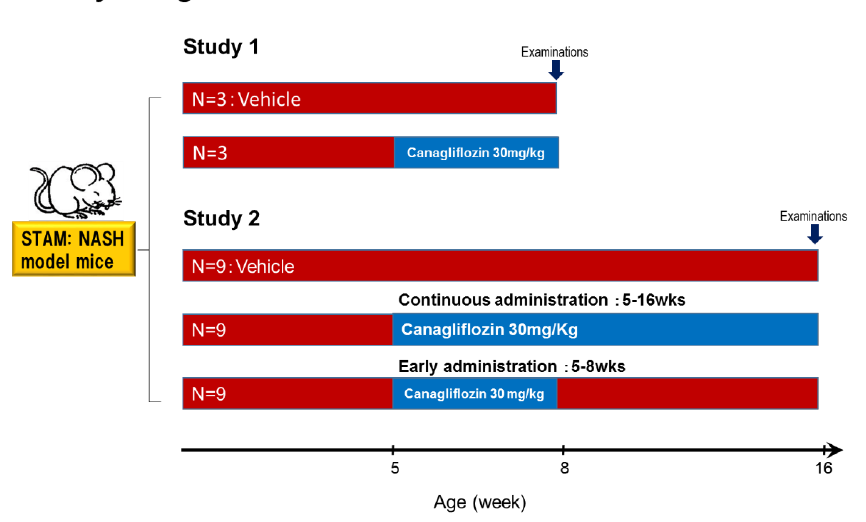
Figure 1. Study design. NASH mice aged five weeks were divided into the vehicle group or canagliflozin (30 mg / kg) group. After grouping, canagliflozin was administered once daily by oral gavage for three weeks. Study 2. NASH-HCC mice aged 5 weeks were divided into three groups of nine animals: vehicle; canagliflozin early administration 30 mg / kg (5 to 9 W); and canagliflozin continuous administration 30 mg / kg (5 to 16 W). After 16 week-treatment, the mice were sacrificed for the collection of liver tissue samples and blood was obtained via cardiac puncture just after death. After grouping, canagliflozin was administered once daily by oral gavage for four and 11 weeks.